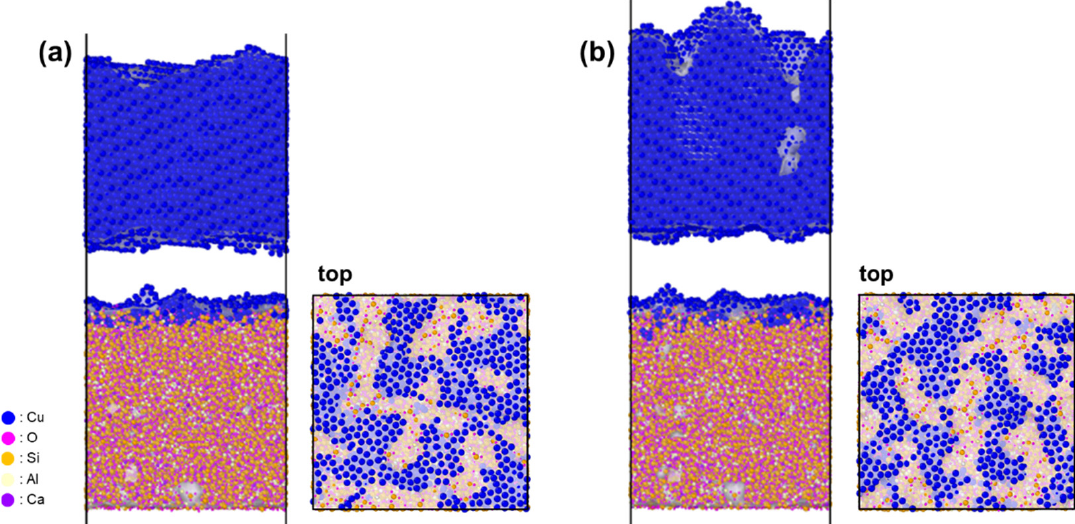
Figure 8. Adhesive failure of Cu-CAS bilayer and top view of the surface after the failure for ( a ) high E Inc and ( b ) low E Inc cases.